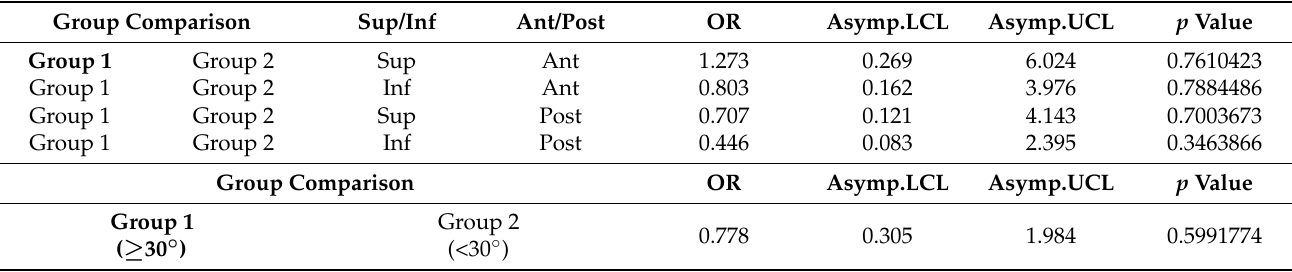
Table 8. Linear mixed models for PI